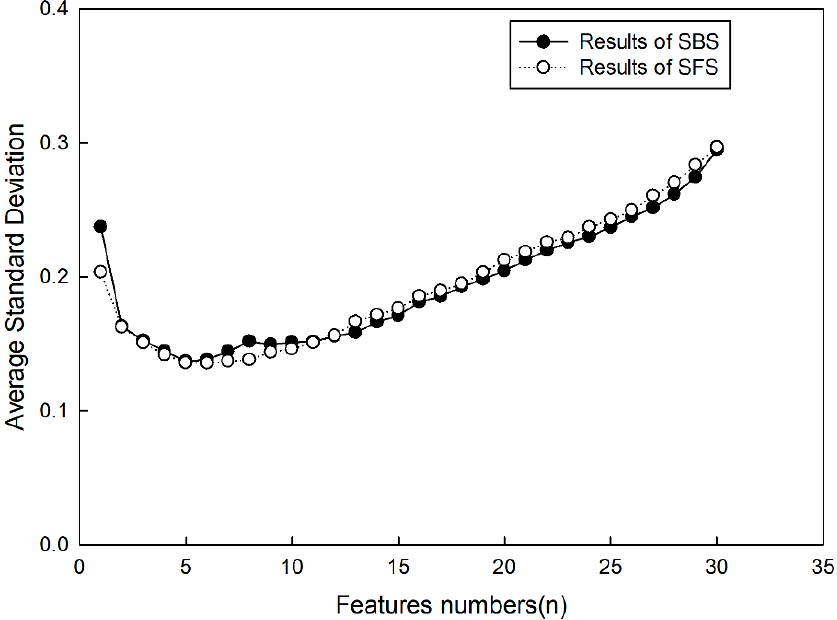
Figure 7. Average standard classification deviation.